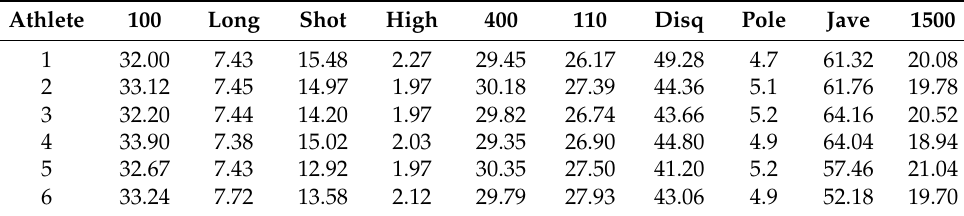
Table 1. Performance results of the first six out of 33 decathletes at the Olympic Games 1988 [5]. Distances are given in meters, time values for the running disciplines are given as speed